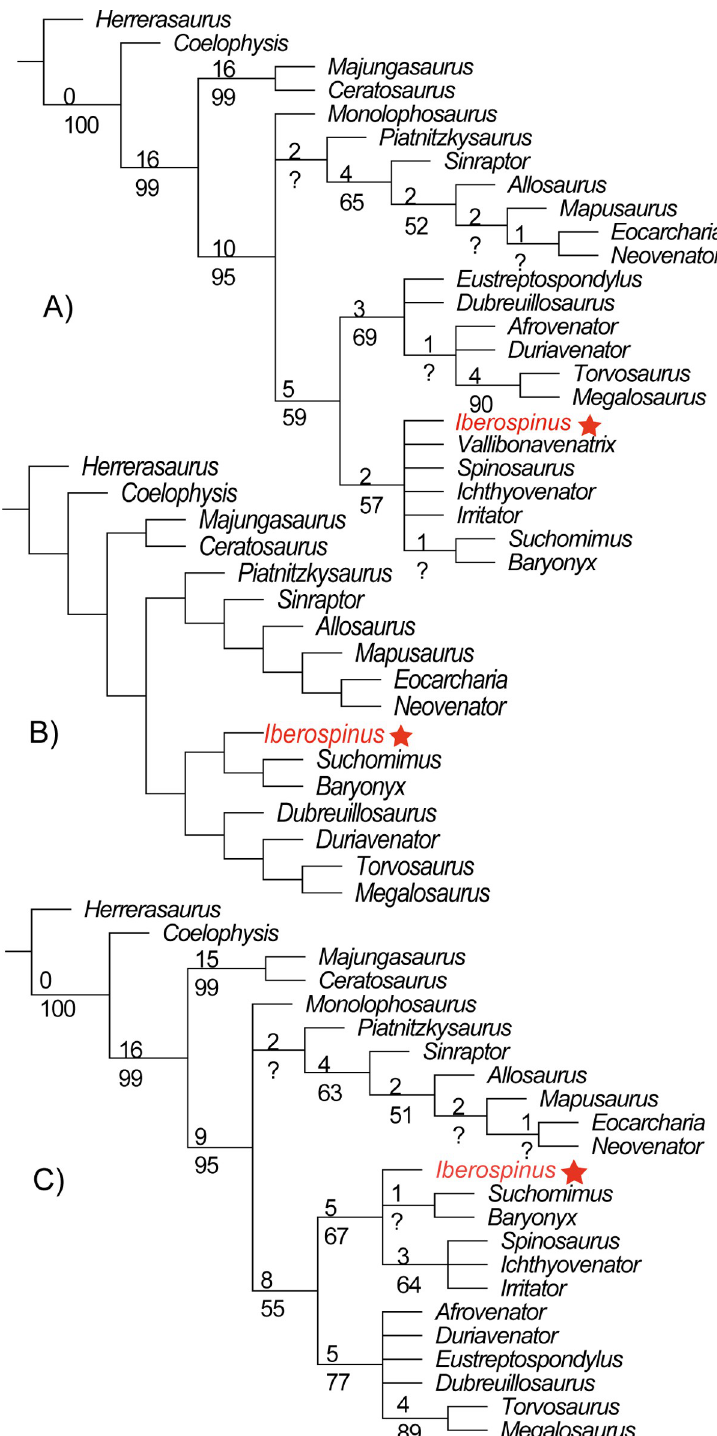
Fig 31. Cladograms including Iberospinus natarioi (ML1190) and other 23 theropods, generated with the software TNT 1.5 (No taxon limit). A , Strict consensus tree including all the taxa in the analysis; B , Agreement subtree; C , strict consensus tree pruning the taxon Vallibonavenatrix cani . Bremer support for the node is shown above the branch; Bootstrap value for the node is below the branch.